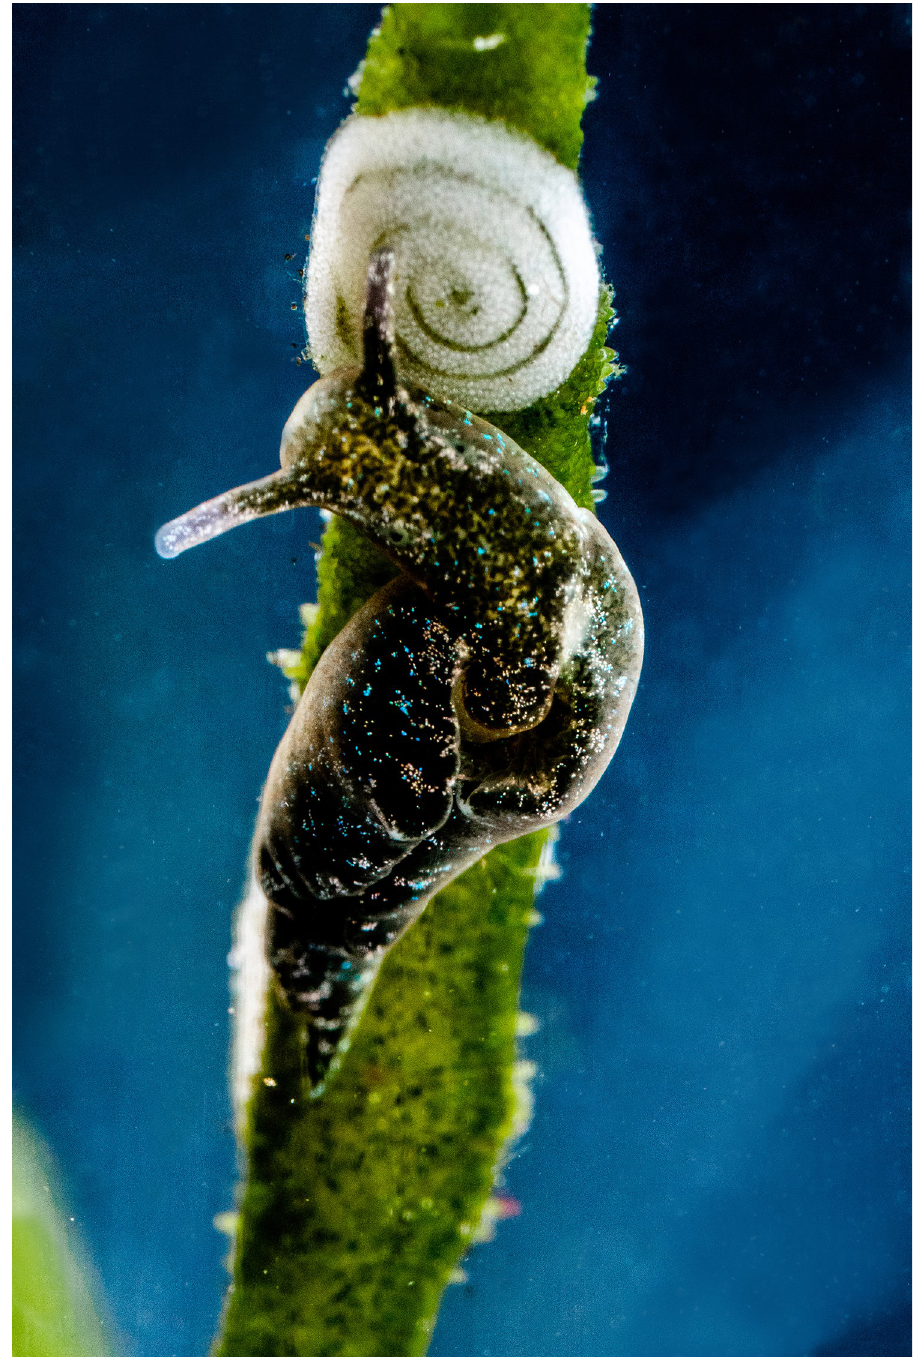
Fig 2. Photosynthesis and reproductive output. Elysia viridis spawning an egg mass on the macroalga Codium tomentosum . Photosynthesis by long-term functional kleptoplasts can support the reproductive output of the host